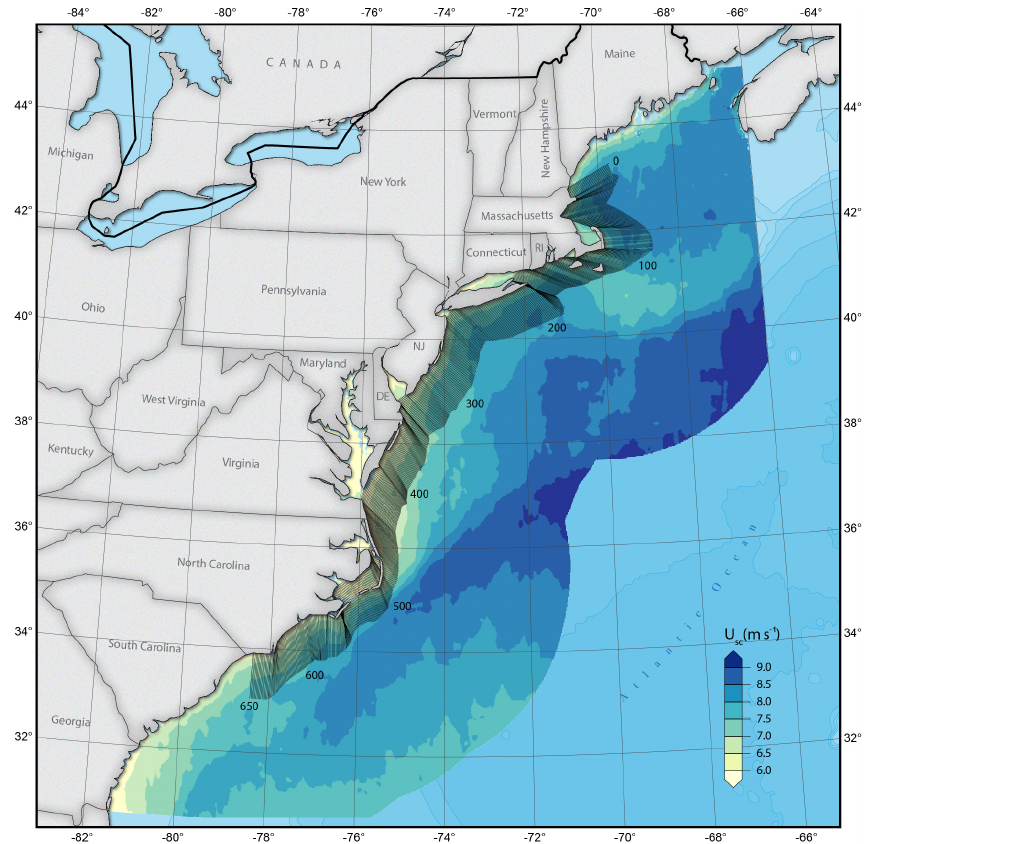
Figure 9. Seasonally corrected SAR mean wind speed maps (SAR_SC) with transects perpendicular to shore (every fifth transect is plotted). Starting at transect_id 0 in the Gulf of Maine going to transect_id 650 off North Carolina.